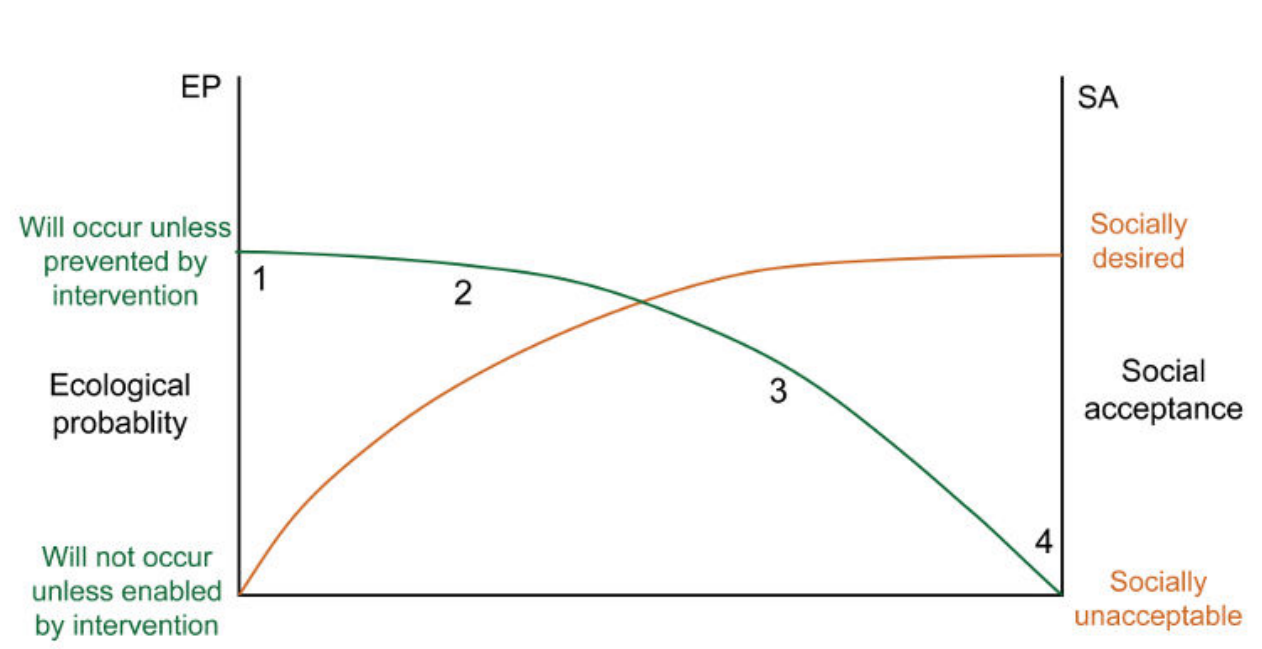
Fig. 1. Conceptual relationships of ecological probability vs. social